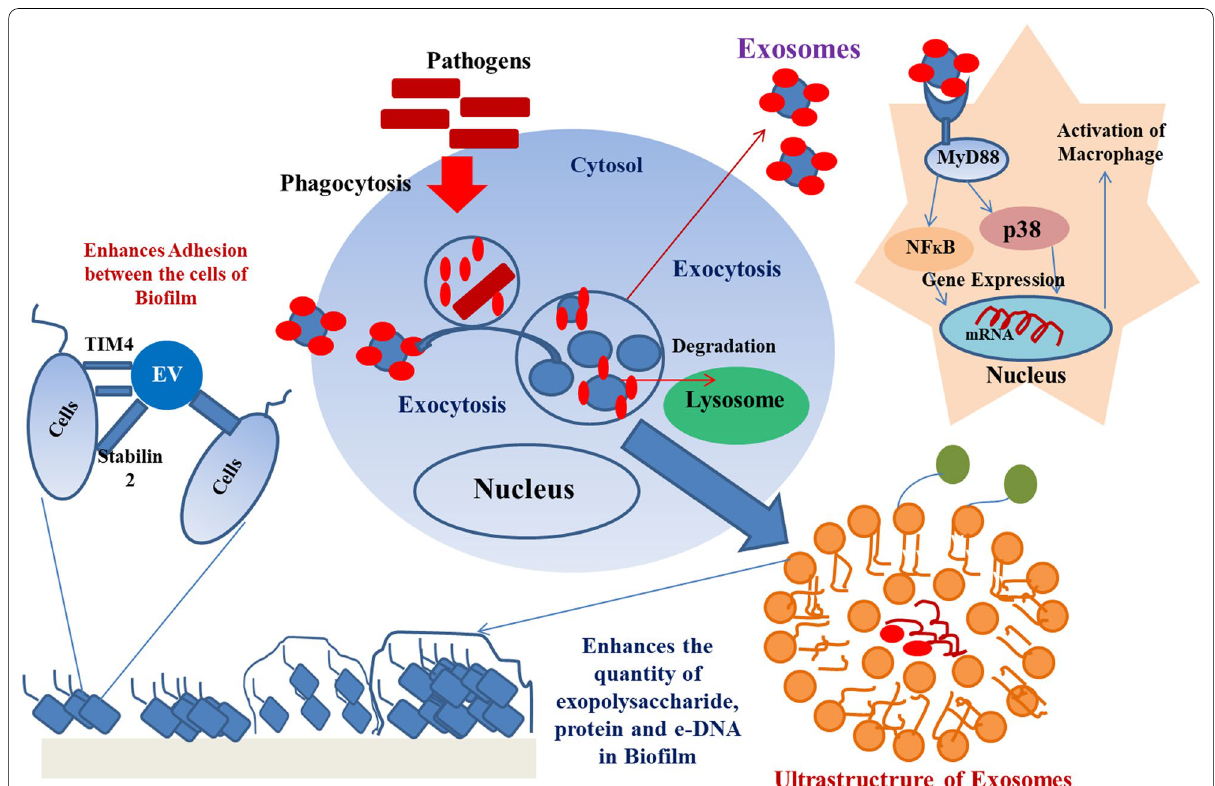
Fig. 3 Schematic representation of biogenesis of exosome, its role in biofilm formation and evasion of host immune